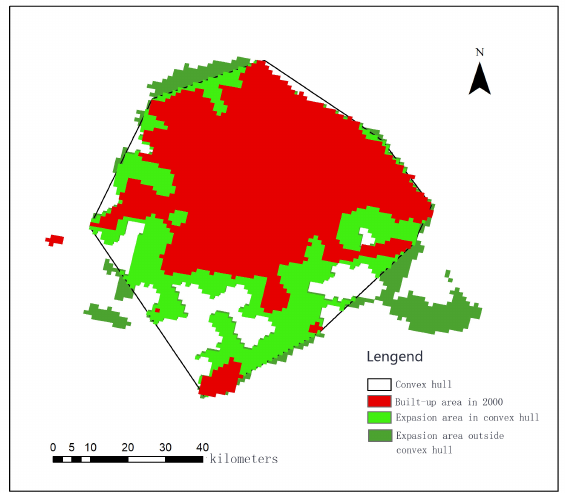
Figure 8 . Urban built-up area expansion in Shanghai from 2000a to